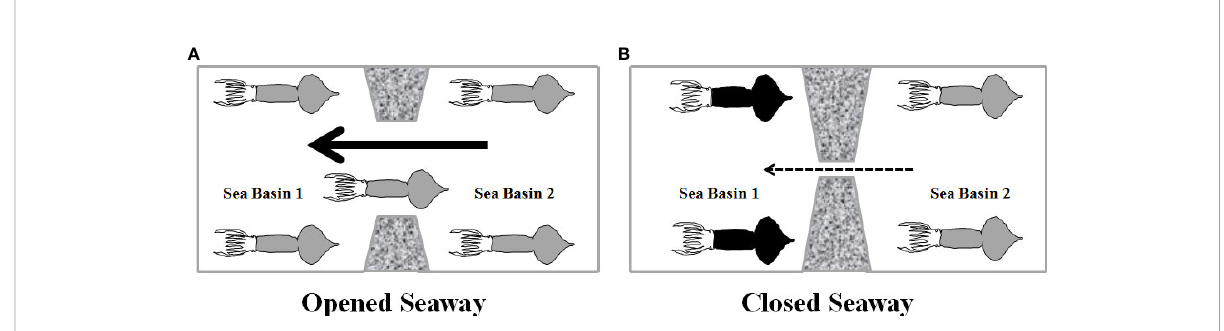
FIGURE 7 Biogeographic role of seaway in marine organisms: (A) genetic homogenous population between two oceans due to high migration rates carried by strong through fl ow through open seaway. (B) Habitat fragmentation and population divergence between two sea basins attributed to weak through fl ow and reduced gene fl ow through closed seaway. Solid and broken arrows indicate strong and weak through fl ows,